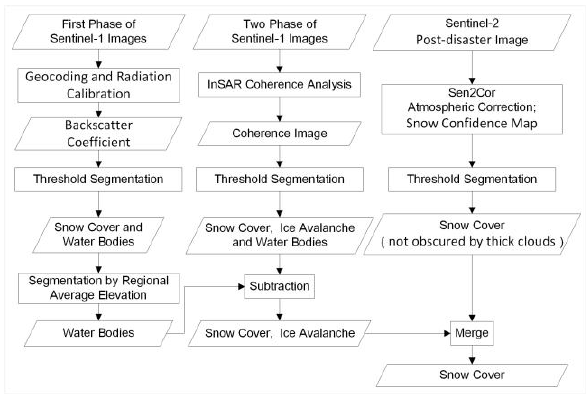
Figure 4. Flow chart of the snow cover mapping process